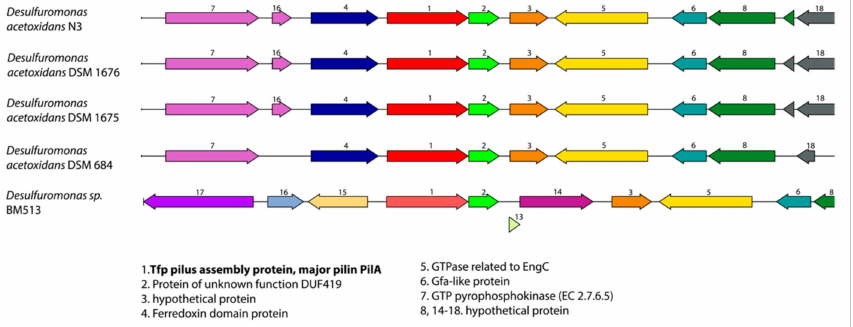
Figure 7. Gene organization comparison around the geopilin-PilA pilus assembly protein in Desulfuromonas genomes. Genes are colored according to protein family (PGFam). The gene for the large major pilin protein PilA, discussed in the text, is marked in